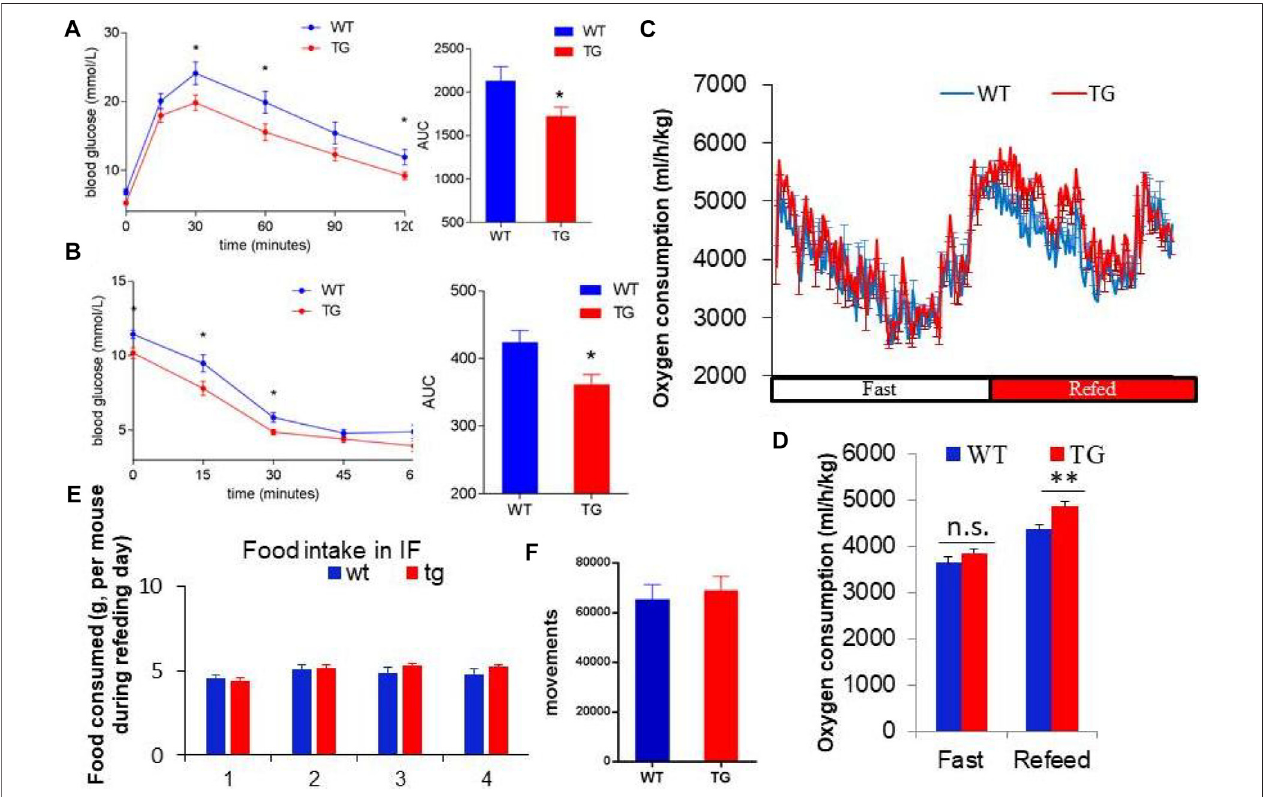
FIGURE2| PZP-meditatedimprovementsinmetabolismdependonenergyexpenditure. (A,B) Bloodglucoseconcentrationateachtimepointandareaunderthe curveoftheglucose tolerance test (GTT) (A) andinsulintolerance test (ITT) (B) . (C,D) Oxygenconsumptionrate (C) and energy expenditure (D) ofWTand